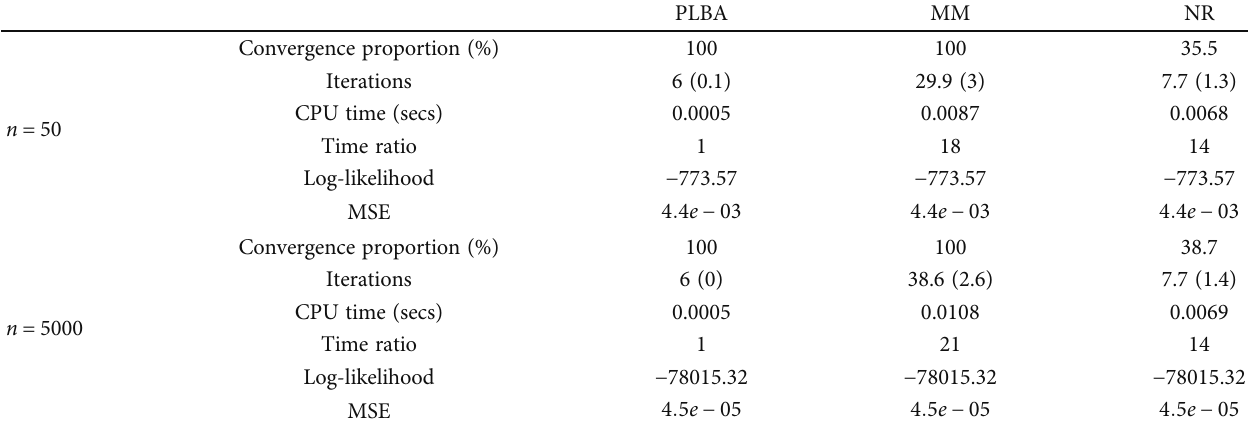
Table 3: Results for Scenario 2 (values in brackets are standard deviations).